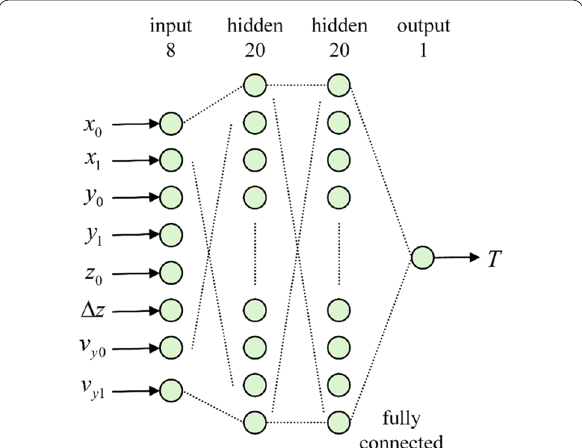
Figure 6 Neural network structure of trajectory time